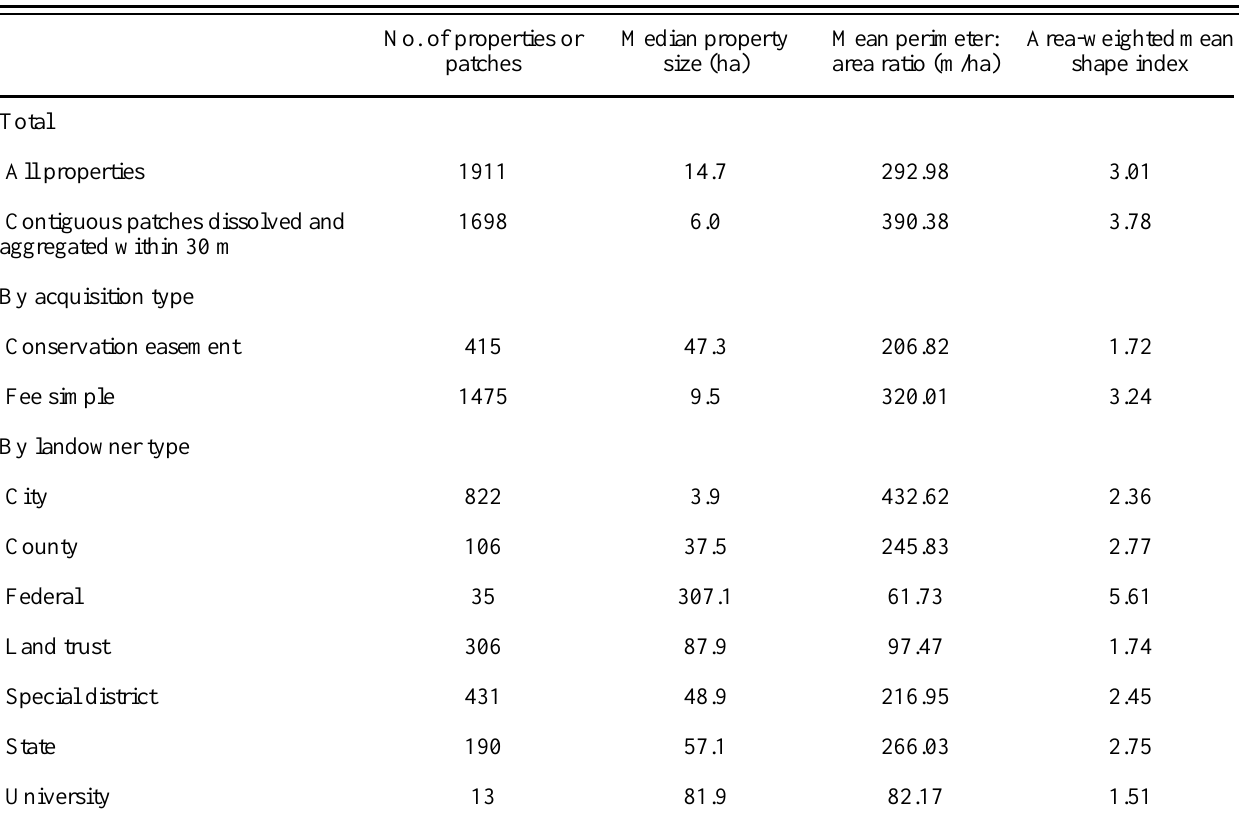
Table 4 . Protected area property size and shape indices by acquisition type, landowner type, total landscape in property units, and total landscape in continguous protected area